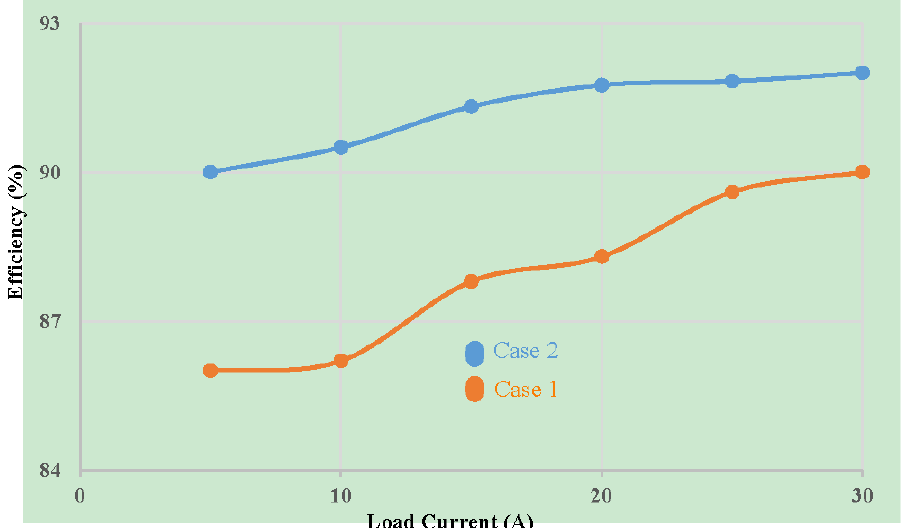
Figure 14. Plot of conversion efficiency of the proposed converter.